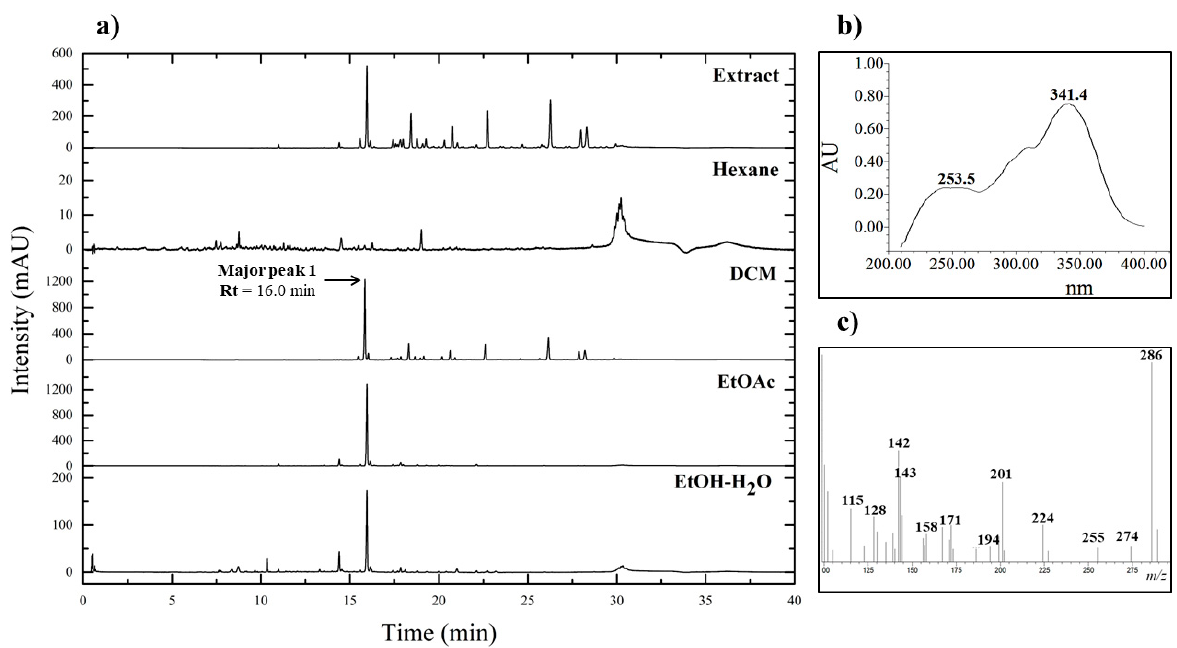
Figure 1. ( a ) Chromatograms corresponding to crude extract and fractions from fruits of P. nigrum obtained by UPLC-PDA at wavelength 260 nm. ( b ) UV adsorption spectrum of major peak 1 with Rt of 16.0 min. ( c ) MS spectrum of major peak 1 with Rt of 16.0 min.